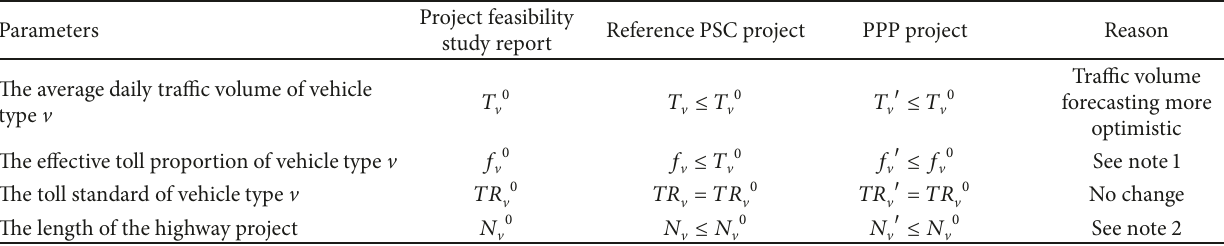
Table 1: Toll revenue calculation parameters